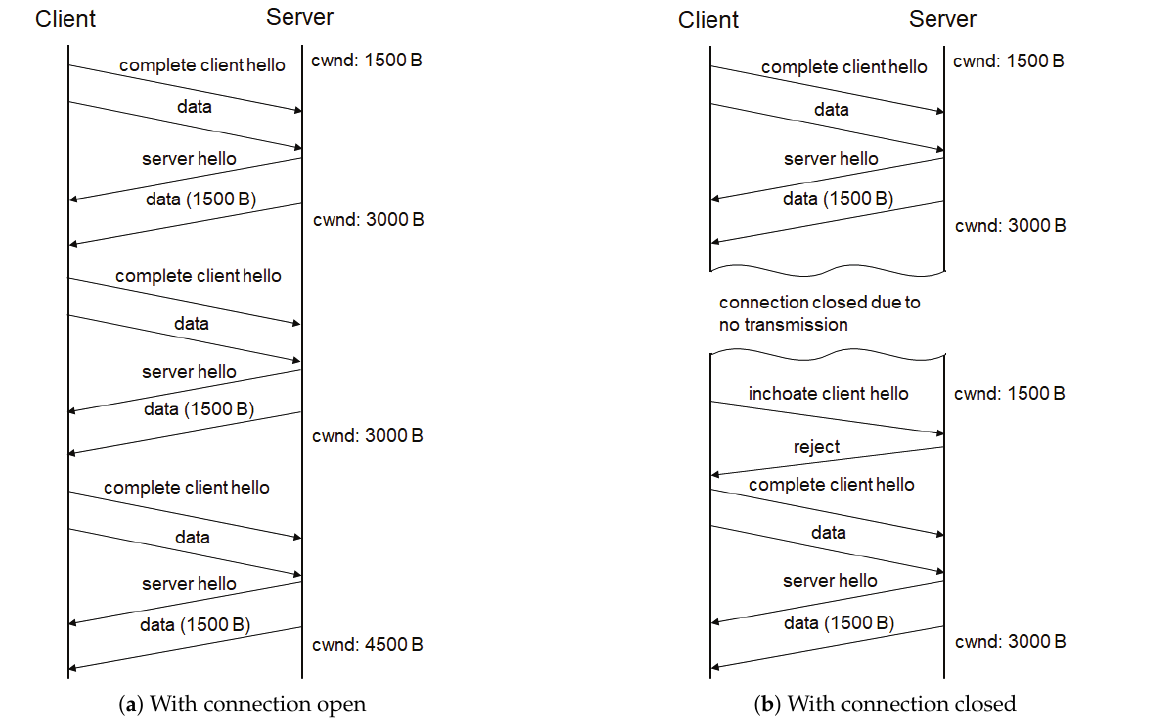
Figure 6. Congestion window variation in the QUIC protocol ( a ) with connection open and ( b ) with connection